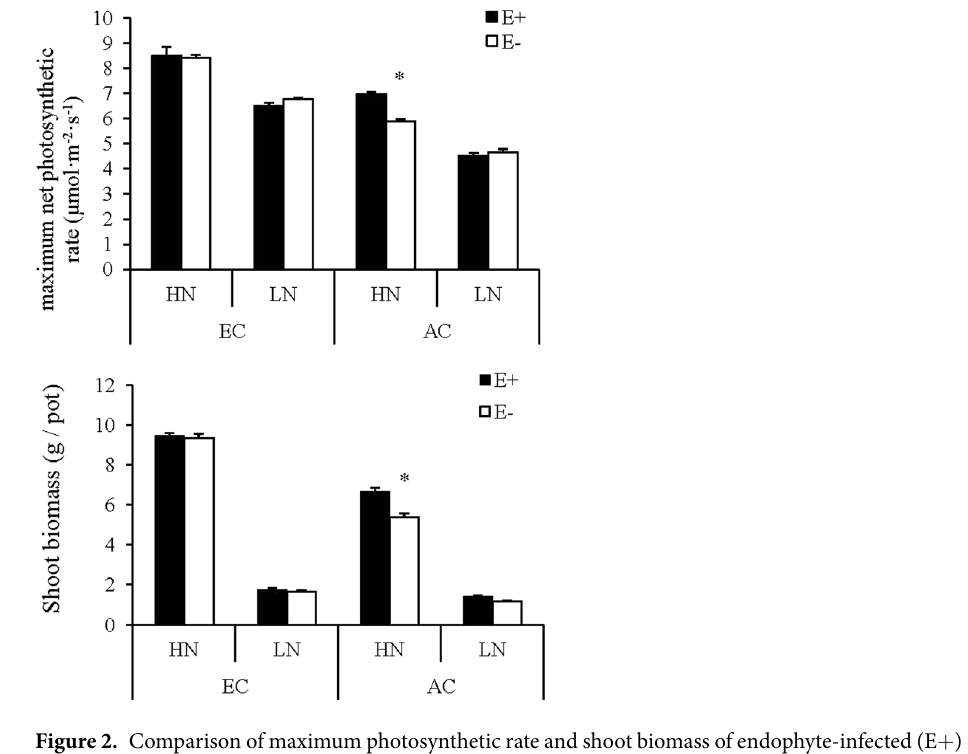
Lesion number and spore concentration of the pathogen. Both lesion number and pathogen spore concentration were significantly affected by the interaction between CO 2 concentration and endophyte infection (Table 2). Under ambient CO 2 concentration, endophyte infection reduced lesion number and pathogen spore concentration of the host leaves when exposed to Curvularia lunata . Elevated CO 2 significantly improved path- ogen resistance of both E + and E − plants. However, no difference occurred in either lesion number or pathogen spore concentration between E + and E − plants under elevated CO 2 (Fig. 4). That is to say, the advantage in path- ogen resistance of E + over E − plants was alleviated by elevated CO 2 . Soluble sugar and amino acids. Soluble sugar concentration was significantly affected by CO tion and endophyte infection (Table 2). Elevated CO 2 significantly increased soluble sugar concentration while endophyte infection significantly decreased soluble sugar concentration of tall fescue (Fig. 5). Because the responses of the 17 amino acids that were measured were not independent, after measurement, we used a PCA to reduce the number of amino acid response variables to a new set of composite variables. To facilitate interpretation of the principal components, we subjected the first four principal components to factor